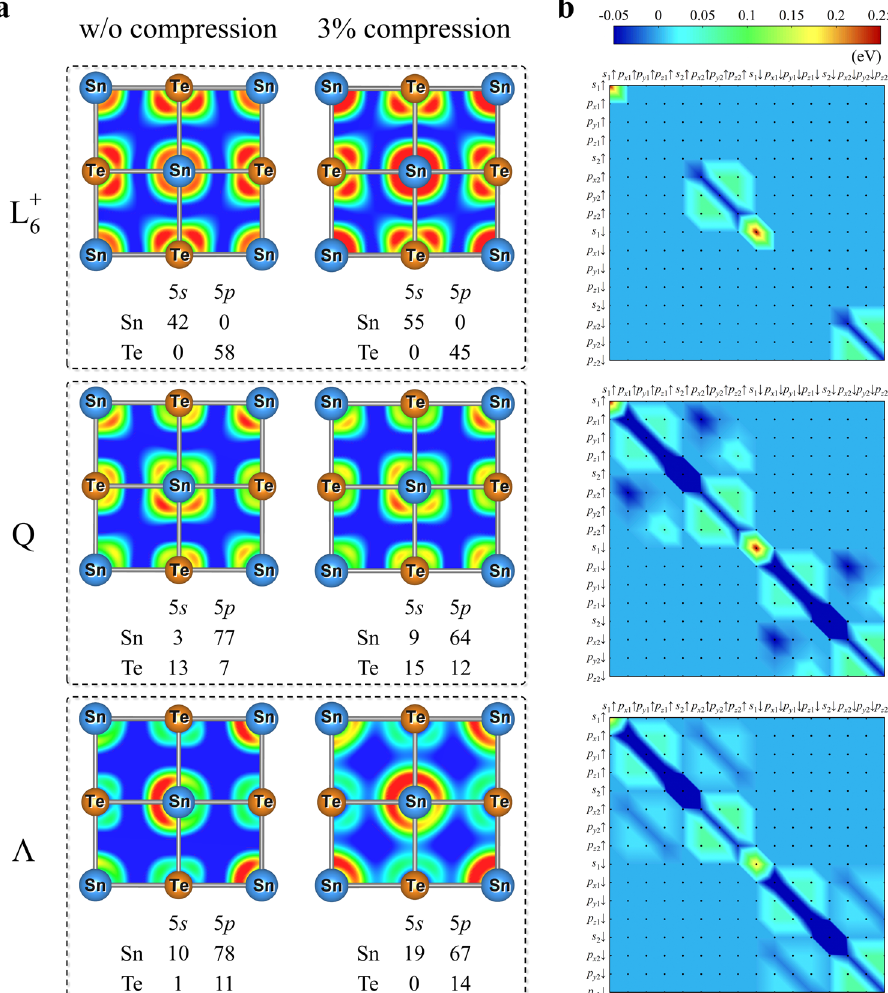
Fig. 2 Orbital contribution to the electron band and tight-binding analysis. a The Wave function squares of L þ onto the (100) plane of the unstrained and 3% compressed SnTe. The numbers below the corresponding fi gures show the atomic orbital components in terms of percentages. b Differences in matrix elements of Hamiltonian at L þ compressed SnTe. The blue and red areas represent the decreases and increases of the Hamiltonian, respectively. It should be noted that although the results are expressed with color gradient maps, only the results displayed on the black points are